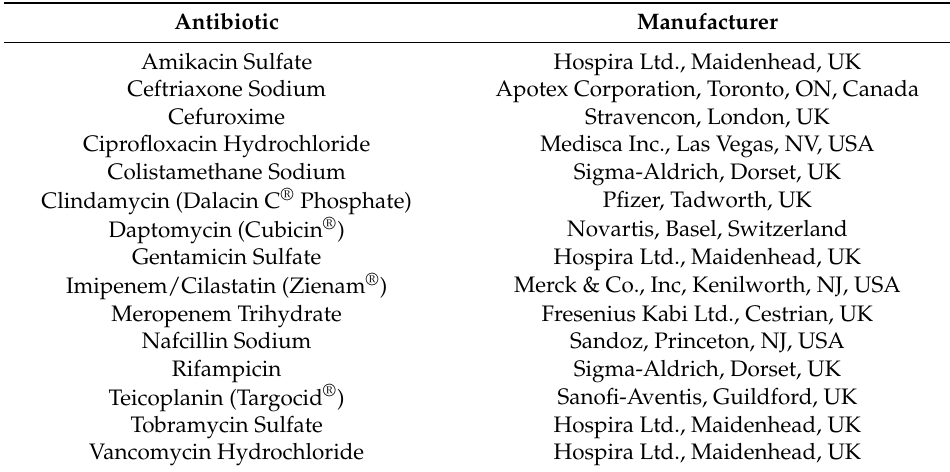
Table 3. Antibiotics tested in this